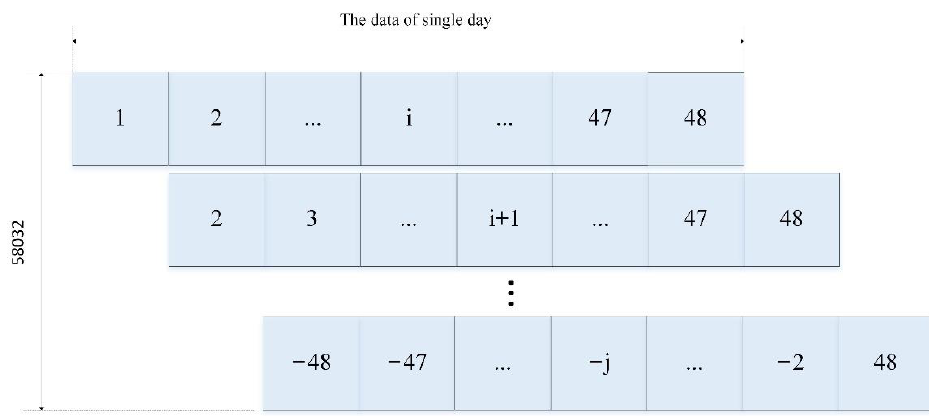
Figure 6. The sliding window method used to obtain samples.